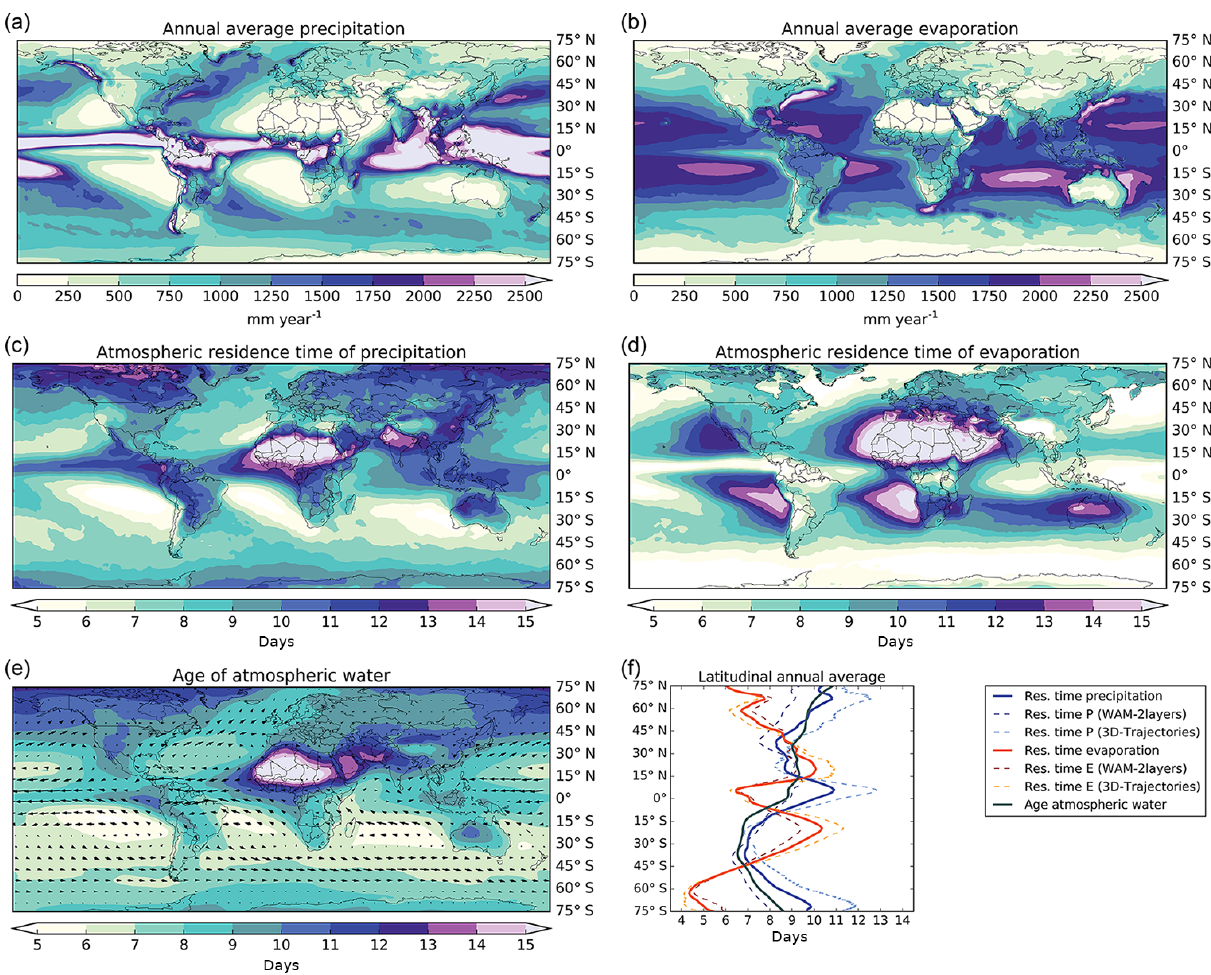
Figure 2. Annual average hydrological cycle, atmospheric residence times and age for 2002–2008, based on ERA-Interim data. (a) Precipi- tation, (b) evaporation, (c) weighted average atmospheric residence time of precipitation (average of WAM-2layers and 3D-T), (d) weighted average atmospheric residence time of precipitation (average of WAM-2layers and 3D-T), and (e) time-averaged age of atmospheric water as it is the atmospheric column (WAM-2layers). The arrows indicate the vertically integrated moisture fluxes. (f) Latitudinal averages. The individual estimates from WAM-2layers and 3D-T for (c) and (d) can be found in the Supplement (Fig. S1). The age of atmospheric water (e) for all days individually can also be found in the Supplement (Animation